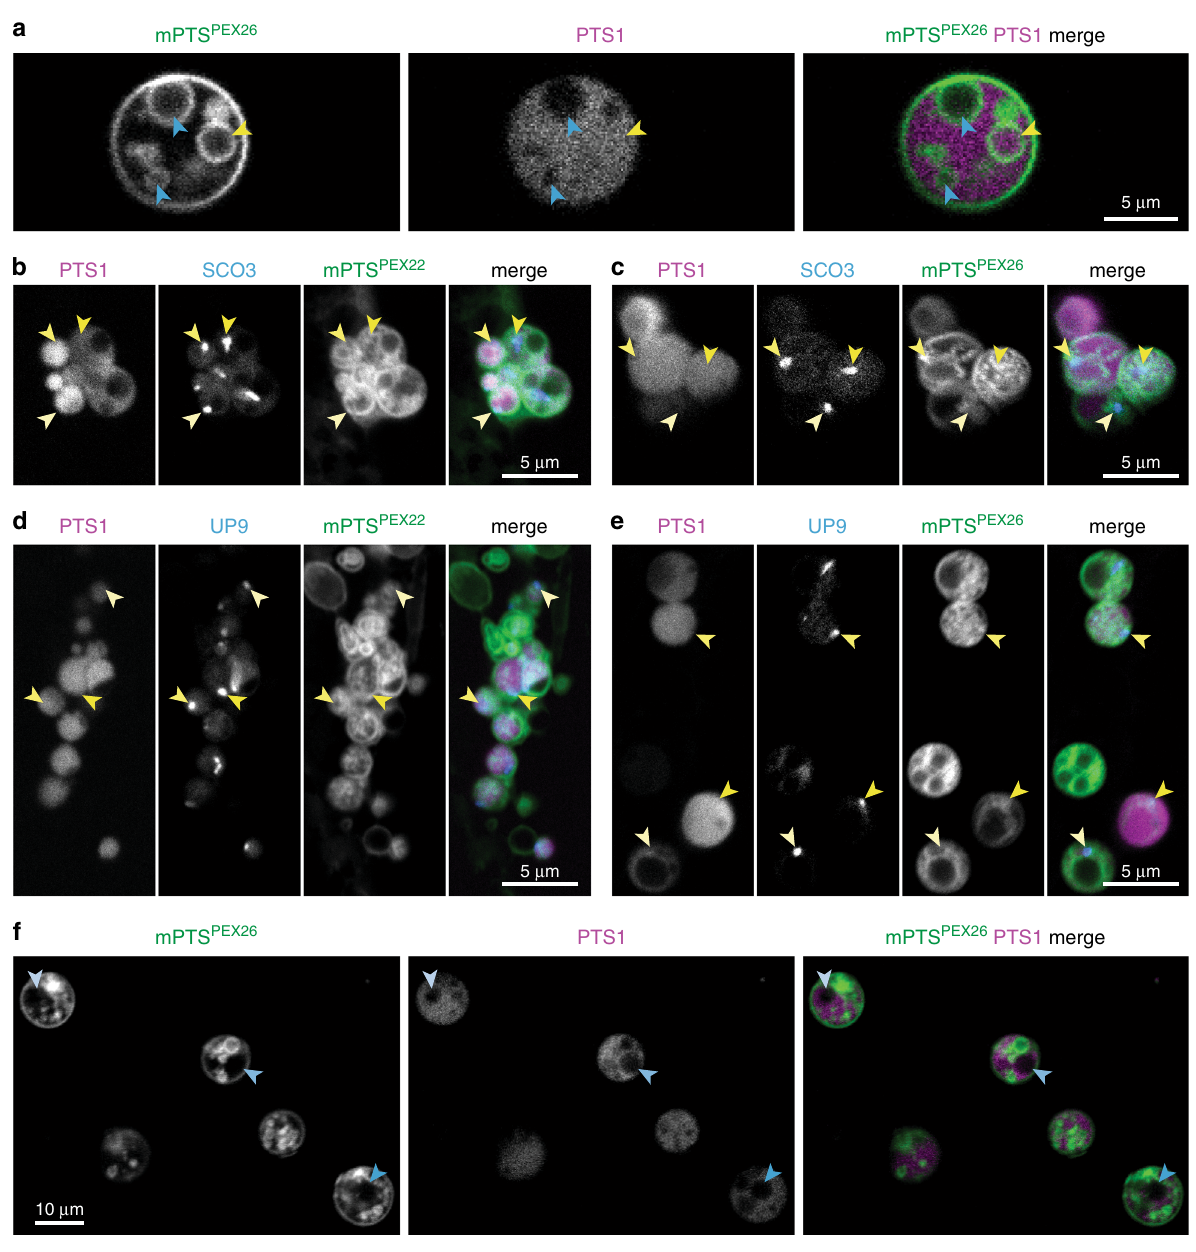
Fig. 6 Peroxisomal vesicles compartmentalize proteins. a Cross-section of 4-day-old cotyledon epidermal cell expressing mNeonGreen-mPTS PEX26 (green) and mRuby3-PTS1 (magenta) shows peroxisomal ILVs enclosing (yellow arrowhead) or lacking (blue arrowheads) PTS1 reporter. b , c Cross- sections of 4-day-old cotyledon epidermal cells expressing mRuby3-PTS1 (magenta), mTagBFP2-SCO3 (blue), and mNeonGreen-mPTS PEX22 (green) ( b ) or mPTS PEX26 -mNeonGreen (green) ( c ) show SCO3 accumulation (arrowheads) in a subset of ILVs. d , e Cross-sections of 4-day-old cotyledon epidermal cells expressing mRuby3-PTS1 (magenta), mTagBFP2-UP9 (blue), and mNeonGreen-mPTS PEX22 (green) ( d ) or mPTS PEX26 -mNeonGreen (green) ( e ) show UP9 accumulation (arrowheads) in a subset of ILVs. f Cross-section of 3-day-old cotyledon epidermal cells expressing mNeonGreen-mPTS PEX26 and mRuby3-PTS1 (magenta) shows ILVs with (green) and without (arrowheads) mNeonGreen-mPTS PEX26 membrane fl